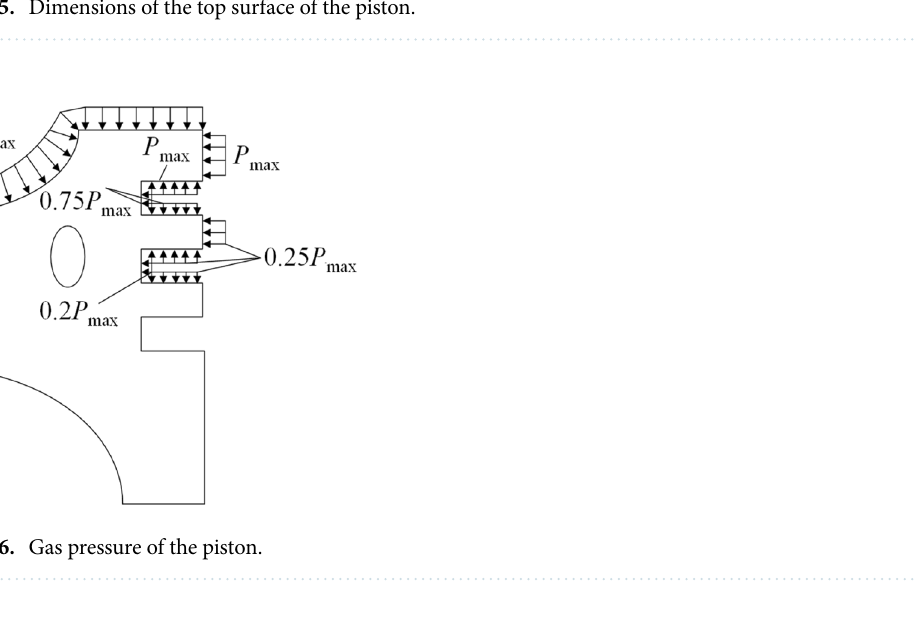
Figure 5. Dimensions of the top surface of the piston.